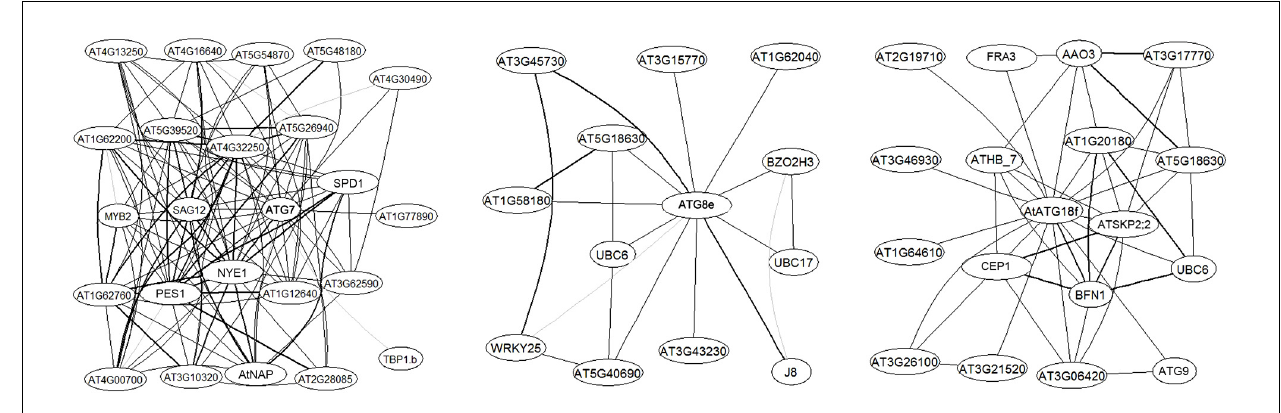
FIGURE 1 | AtATG7 , AtATG8e , and ATG18f are hubs in Arabidopsis transcriptional networks. The network was built as described in Ma etal. (2007). Sub-networks centered on the ATG genes with a maximum of two steps are extracted from the expanded network. Genes are labeled with their